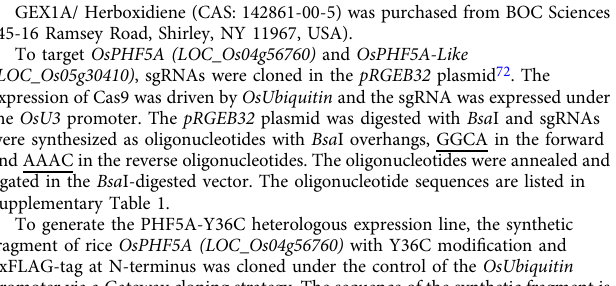
and AAAC in the reverse oligonucleotides. The oligonucleotides were annealed and ligated in the Bsa I-digested vector. The oligonucleotide sequences are listed in Supplementary Table 1. To generate the PHF5A-Y36C heterologous expression line, the synthetic fragment of rice OsPHF5A (LOC_Os04g56760) with Y36C modi fi cation and 3xFLAG-tag at N-terminus was cloned under the control of the OsUbiquitin promoter via a Gateway cloning strategy. The sequence of the synthetic fragment is given in Supplementary Table 1. Rice transformation and genotyping of transgenic plants . Rice transformation was performed using the agrobacterium strain EHA105 and genotyped as described previously 56 . Brie fl y, the sgRNA-targeted region was ampli fi ed by PCR using locus- speci fi c primers. Puri fi ed PCR products were cloned using CloneJET PCR Cloning Kit (K1231). Sanger sequencing was conducted to analyze the mutation. Phenotypic analysis . The germination inhibition assays were performed in six- well culture plates. Rice seeds were surface-sterilized and germinated in 4mL of H 2 O for controls and with 5µM and 10 µM of GEX1A. The germination rate was calculated after 5 d. For the primary root elongation inhibition assay, sterilized rice seeds were germinated on ½ MS agar media (without sucrose) square plates for three days in a vertical position. On the third day, seedlings with similar root lengths were transferred to ½ MS media (without sucrose) supplemented with different concentrations of GEX1A and/or NaCl and grown in a vertical position. The tip of the root was marked and subsequent root growth was calculated after 3